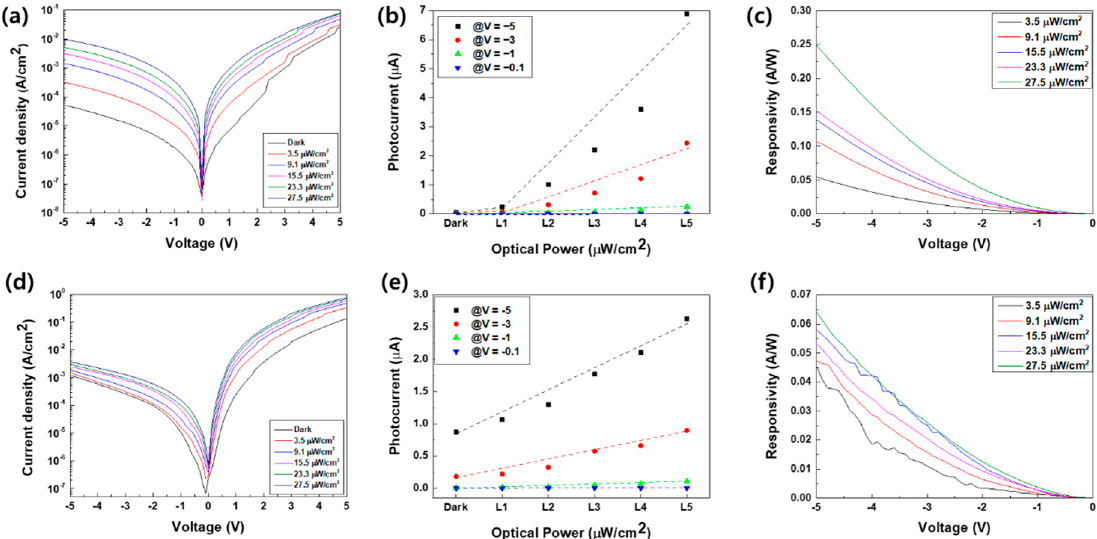
Figure 2. Plots of ( a ) current versus voltage, ( b ) photocurrent versus optical power, and ( c ) responsivity versus voltage for hybrid PD without PVDF-TrFE. Plots of ( d ) current versus voltage, ( e ) photocurrent versus optical power, and ( f ) responsivity versus voltage for hybrid PD with PVDF-TrFE.